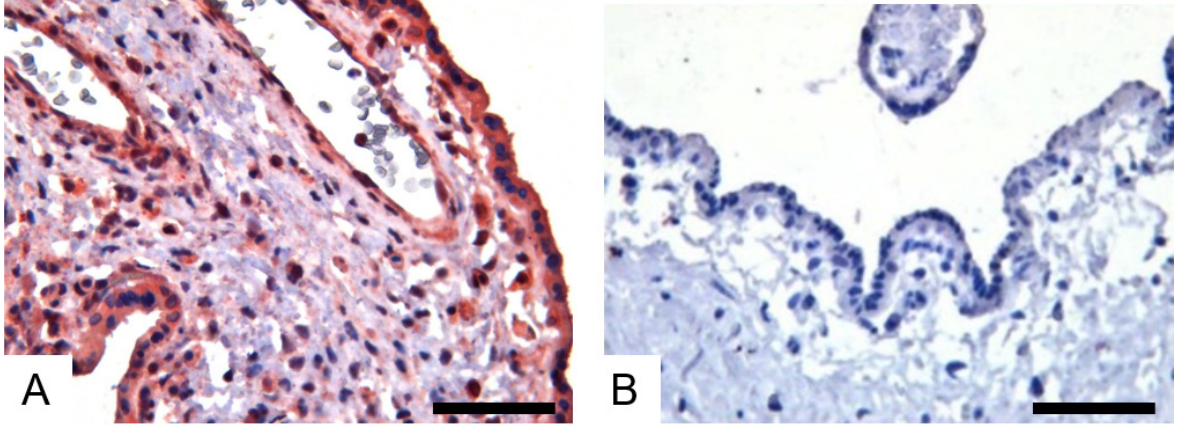
Figure 4. Detection of HA in H1N1/09-infected fresh placenta tissue with IHC. The brown–red color stands for the positive signals. Infection of human placenta ( A ) by H1N1/09. Mock infection of human placenta ( B ) was performed as control. All sections were counterstained with hematoxylin. Scale bar = 50 μ m.